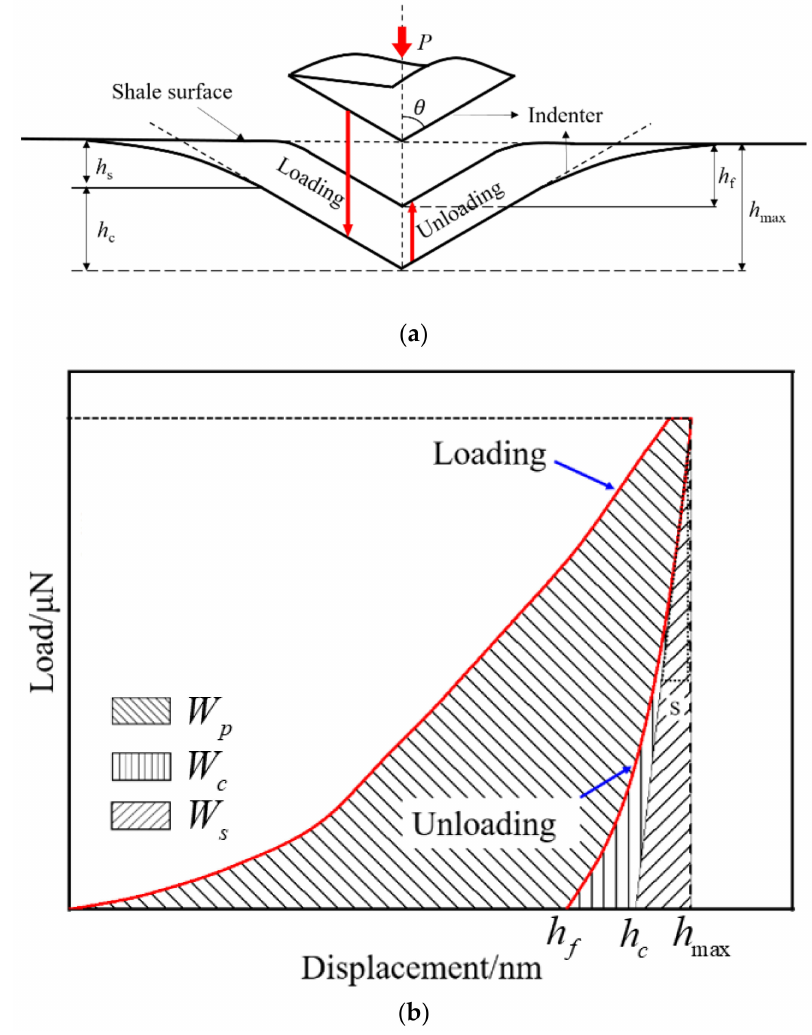
Figure 3. Nanoindentation experiment process: ( a ) schematic diagram of loading and unloading, ( b ) schematic illustration of indentation load-displacement curve. P is the loading stress; S is the contact stiffness; W p is plastic energy; Ws is elastic energy; W c is D -value between plastic energy and pure plastic